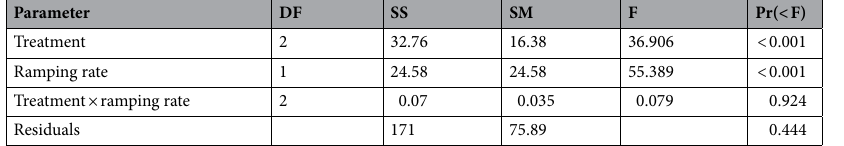
Table 2. The effect of acclimation treatment and ramping rate on CT max . DF = degrees of freedom, SS = sum of squares, SM = mean sum of squares, F = F ratio, Pr(< F) = p value associated with the F-statistic.